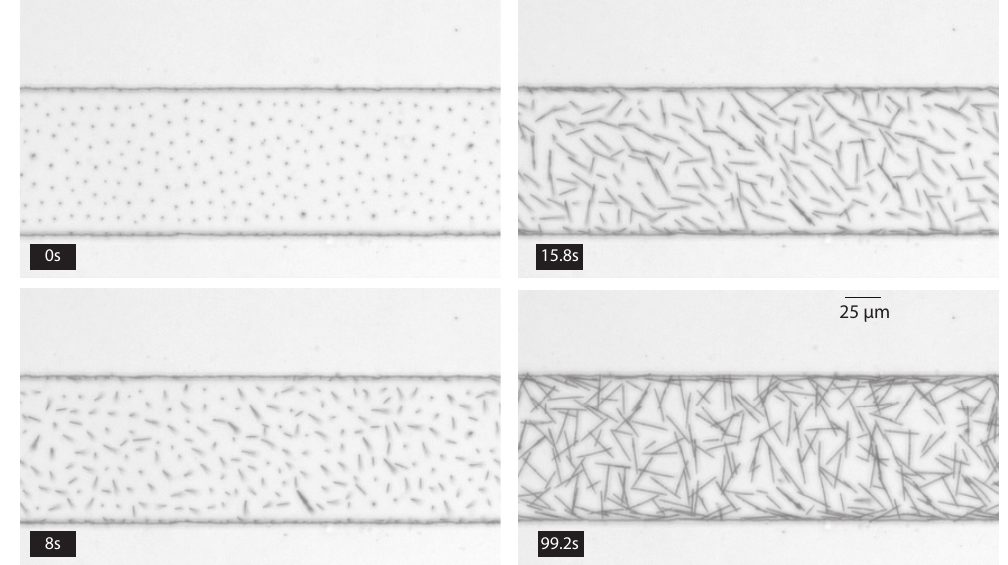
Figure 7. Successive photographs of the channel from above starting when the magnetic field is removed until the end of the sedimentation of fibers to the bottom of the channel. The channel height (and fiber length) is 28 µ m. A video of these fabrication steps is available in Supplementary Materials Video